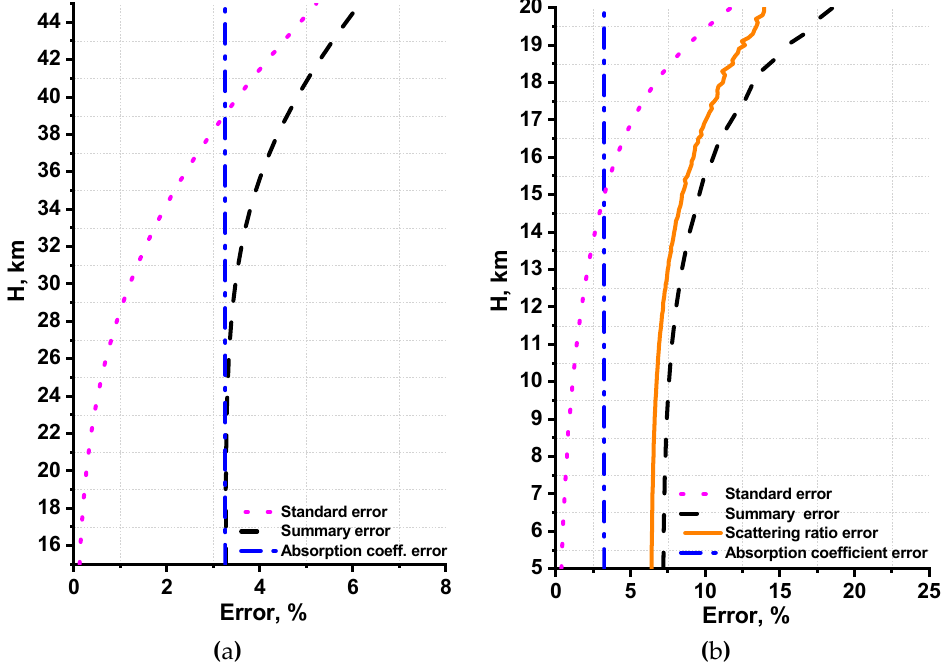
Figure 2. Average measurement errors of ozone vertical distribution (OVD) for 2018: error in the ( a ) stratosphere and ( b ) upper troposphere–lower stratosphere.